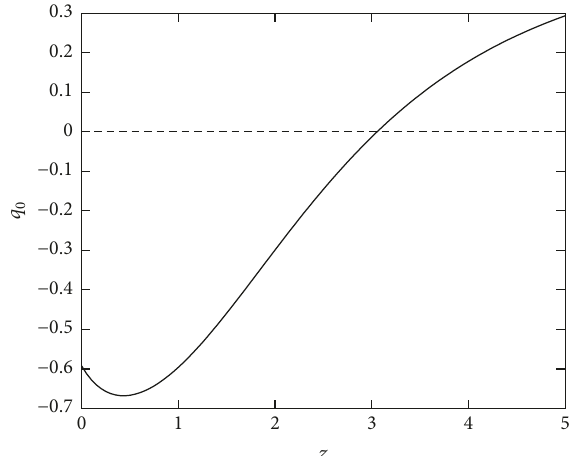
Figure 4: The deacceleration parameter 𝑞(𝑧) of (22) for the model defined by (25), (26), (29), and (30). Notice that the value of the zero 𝑧 𝑞(𝑧) is 𝑧 ∼ 3 . This is much higher than the realistic value 𝑞 of 𝑞 𝑧 ∼ 0.7 obtained in Λ CDM. 𝑞